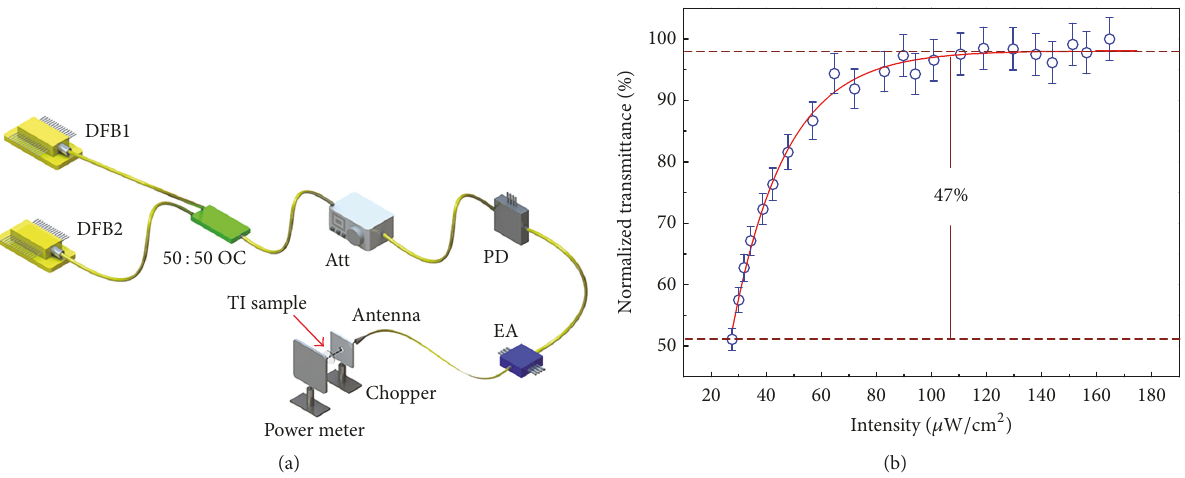
Figure 5: (a) Experimental setup for nonlinear response measurement system and (b) the measured normalized transmittance curve of TI: Bi 2 Te 3 at sub-terahertz band.